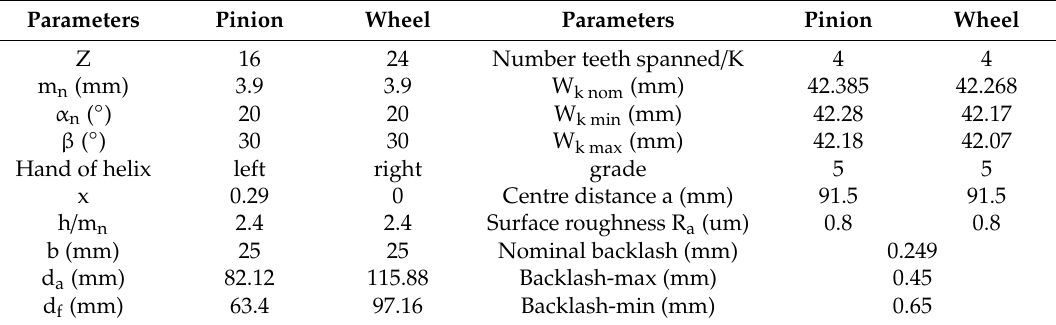
Table 1. Gear parameters of test gears with interference fit connection of conical